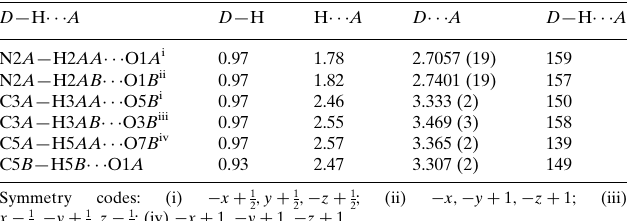
Hydrogen-bond geometry (A˚ , (cid:4)